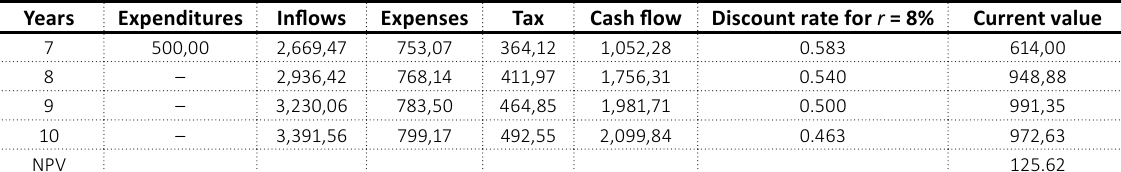
Source: Own study.